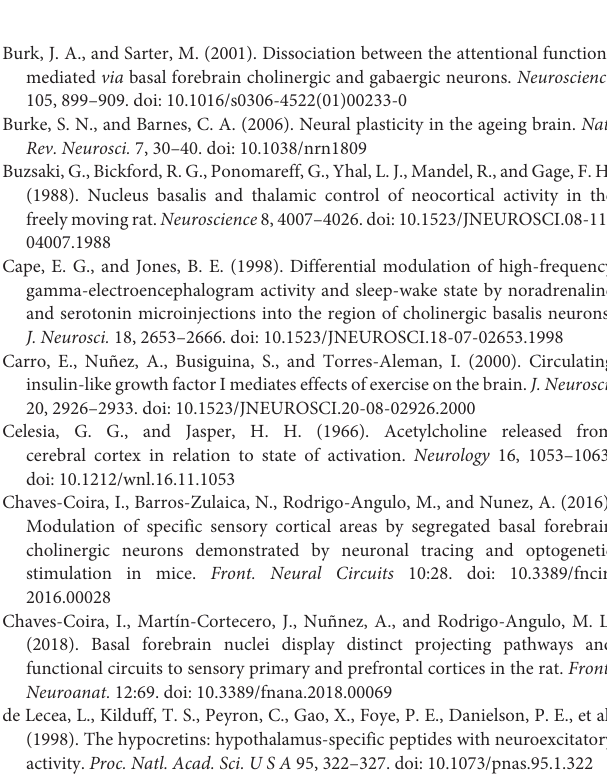
SUPPLEMENTARY FIGURE 1 | (A) Diagram of the optrode and the cannula location in the HDB nucleus (upper inset). Lower: Representative photomicrograph of ChAT+ cell (red) and orexin receptor-A. Cholinergic neurons expressed orexin receptor-A. The bar in (A) is 50 µ m. (B) Optogenetic identification of ChAT+ cells in old mice (ChAT-ChR2-YFP animals; ≥ 18 months old). ChAT+ identified neurons increased their active during light pulse (at 0–100 ms, 120.6 ± 3.916; ∗∗∗ p < 0.001, and at 100–200 ms, 117.2 ± 6.345; ** p = 0.0044, n = 42 neurons; over basal, 100 ± 0; Friedman test, Dunn’s multiple comparison test. (C) Orexin-A injection in HDB (10 nM; 0.2 µ l) increased both young and old mice’s firing rate. The firing rate in both experimental groups